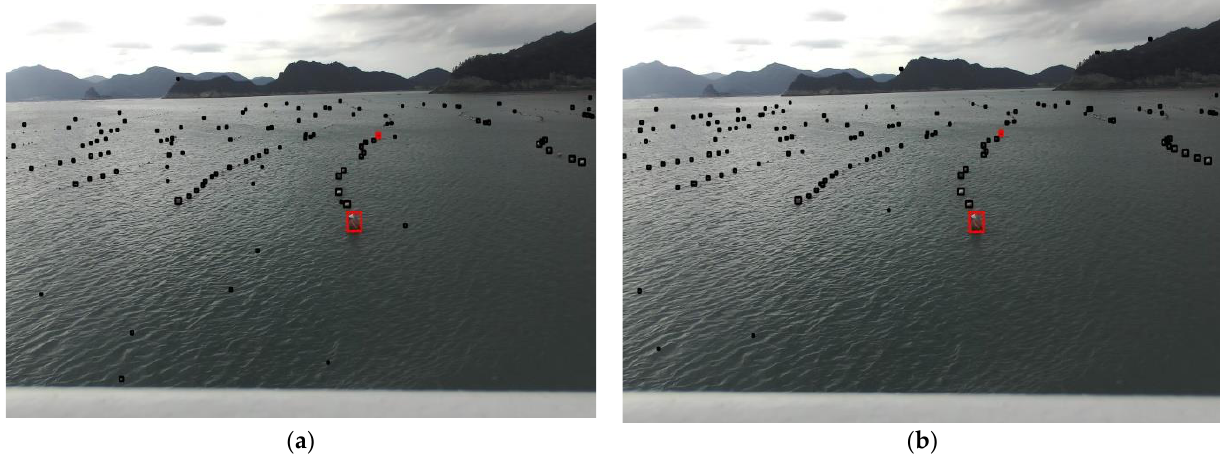
Figure 19. Area-based stereo matching results (Experiment B): ( a ) SSD and ( b ) NCC.